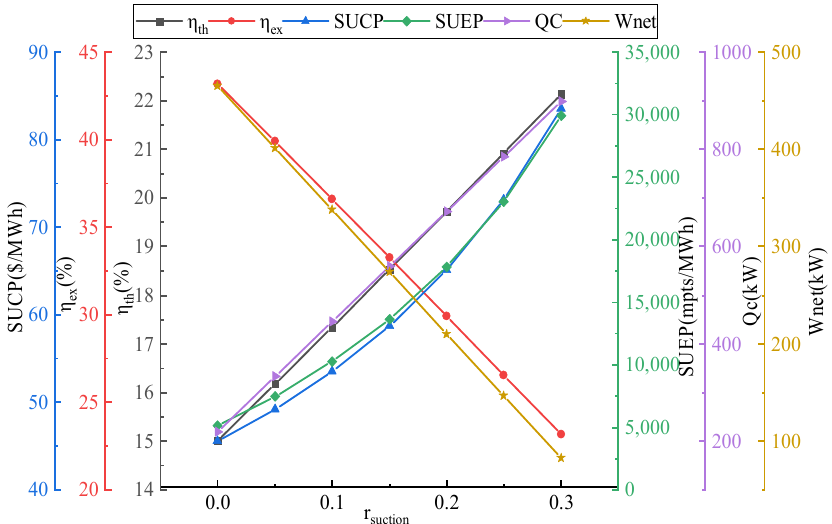
Figure 6. Effect of ratio of suction from the steam turbine on system performance.